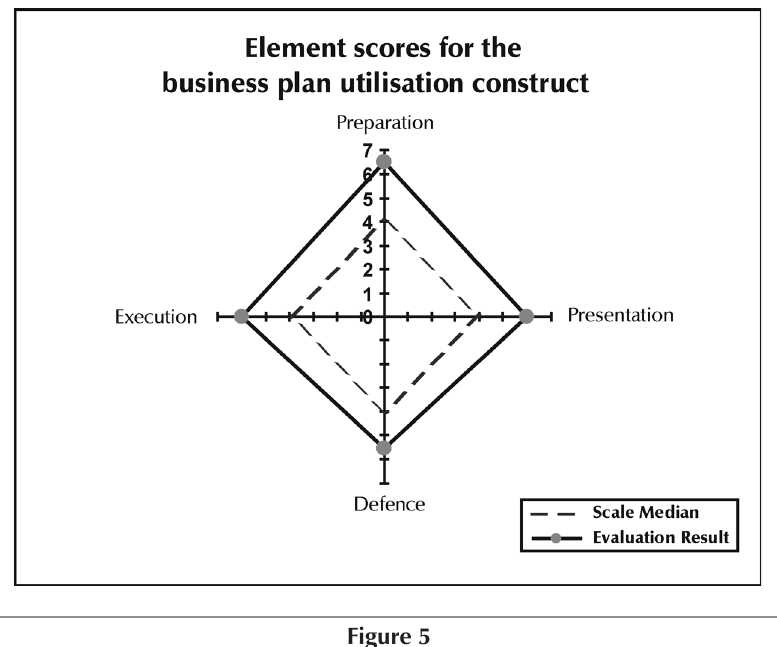
Graphical representation of evaluation results for the elements of the business plan utilisation construct of the NVCL compared to the